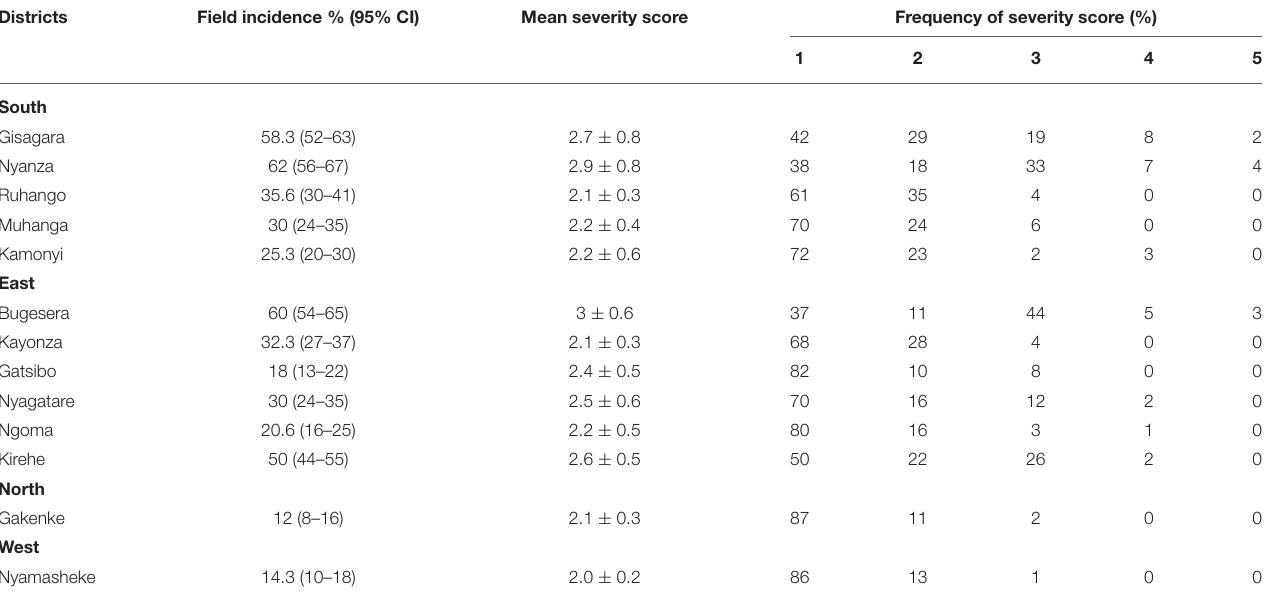
TABLE 1 | Field incidence, severity, and frequency of cassava plants showing aerial CBSD symptoms in Rwanda, 2019.